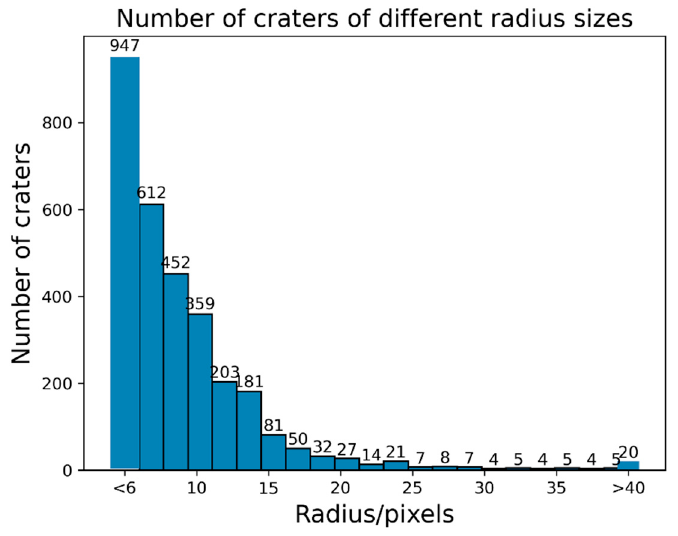
Figure 10. Number of craters with different radius sizes in the Bandeira database.